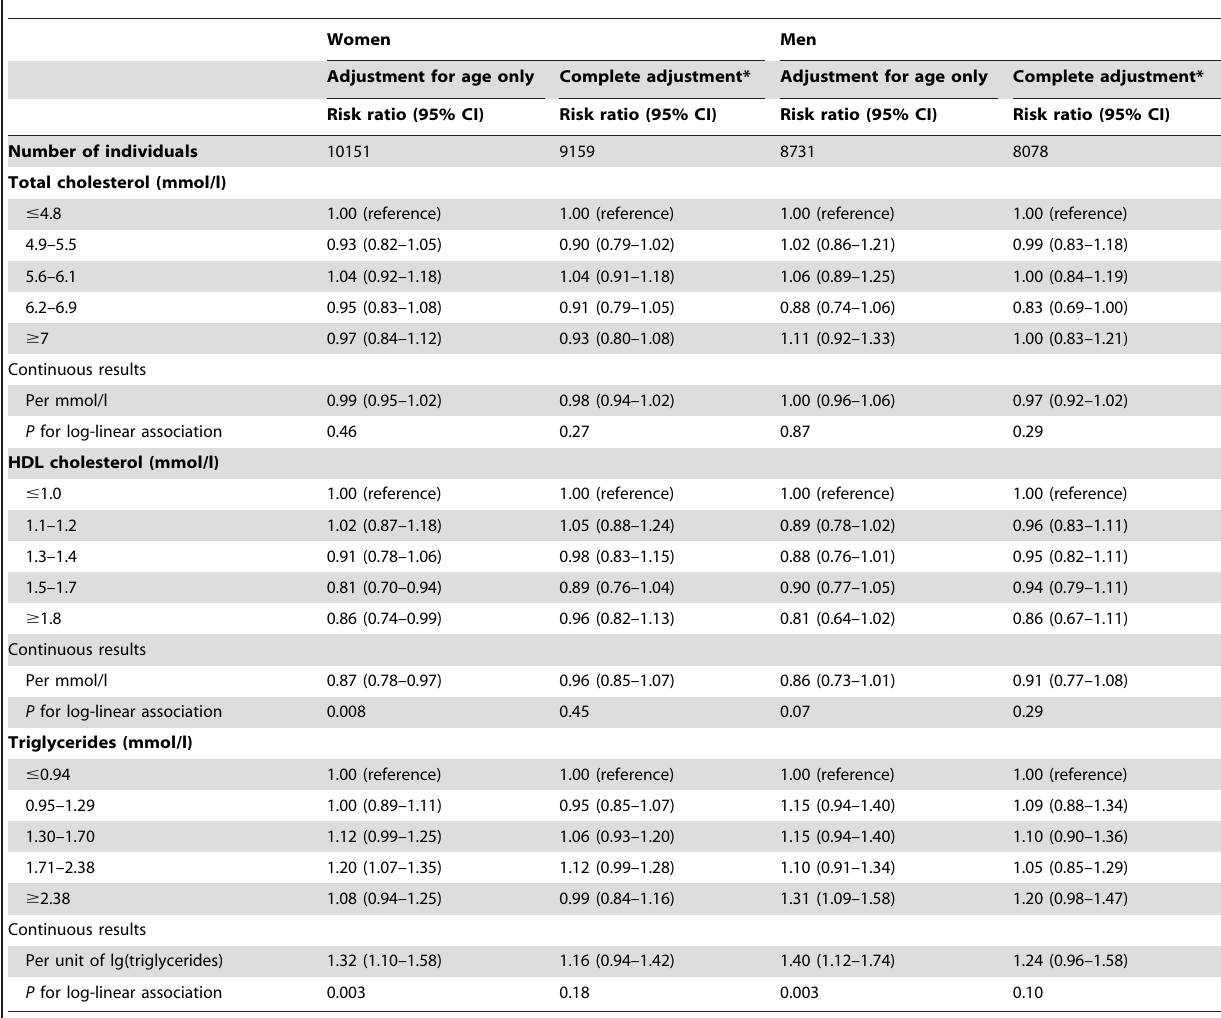
Table 2. Associations between lipid levels and risk of chronic LBP among individuals without chronic LBP at